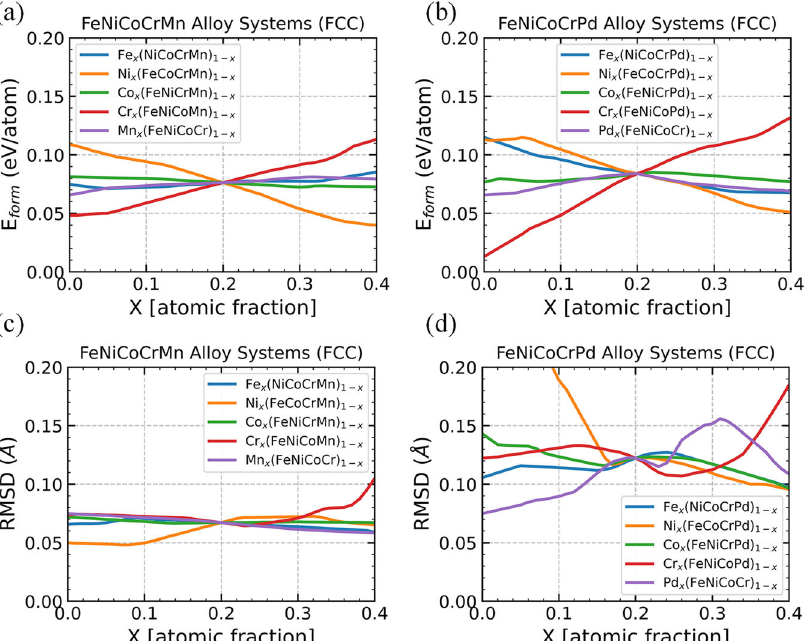
Fig. 7 Machine learning predictions of formation energies and RMSD for two quinary FCC solid state systems as the function of the atomic fraction X (X is the atomic fraction of one element as the principal and (1-X) for other four elements in equi-atomic concentrations). a , c FeNiCoCrMn; b , d